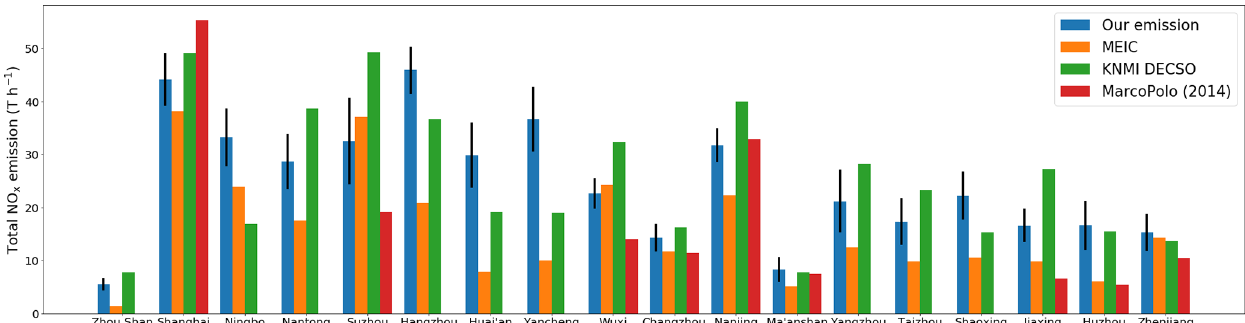
Figure 8. Total anthropogenic NO x emission in each city for the summer months of 2012–2015 derived here, in comparison with other emission datasets. Soil NO x emissions calculated by the nested GEOS-Chem and biomass burning NO x emissions from GFED4 have been subtracted from our emission data and DECSO. Black vertical lines denote the uncertainty (1 σ ) of our